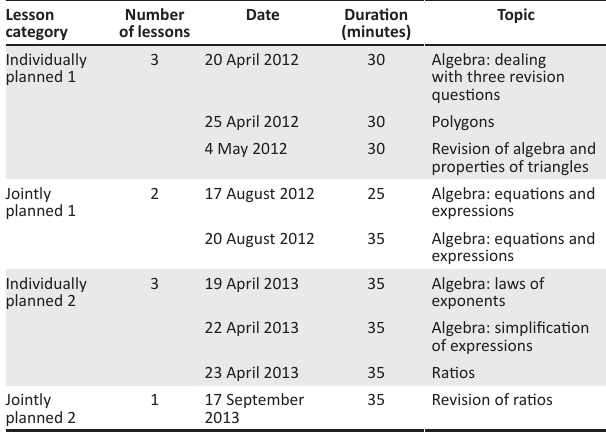
TABLE 1: Overview of the types of